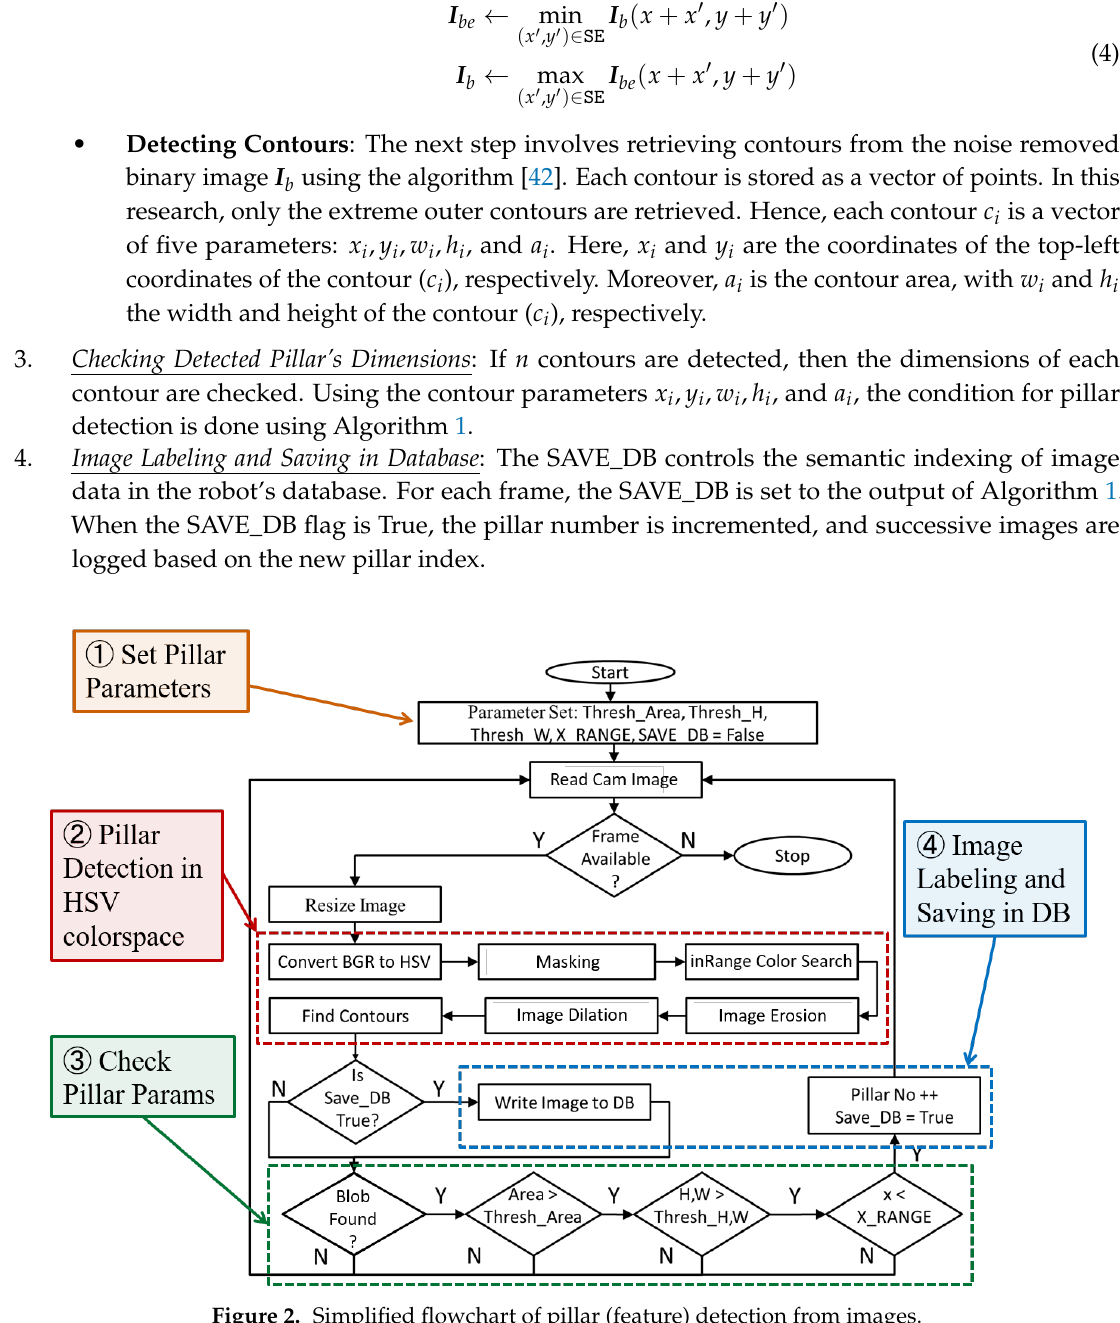
Figure 2. Simplified flowchart of pillar (feature) detection from